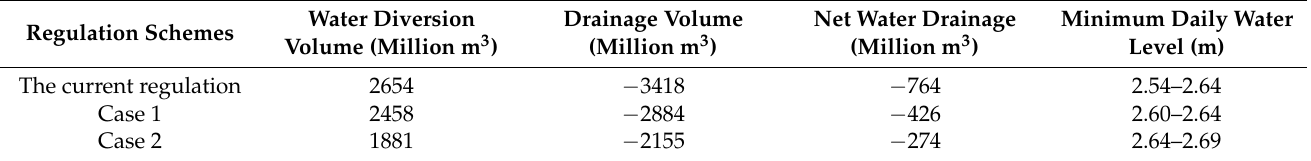
Table 3. The comparison of the two optimal regulation schemes.